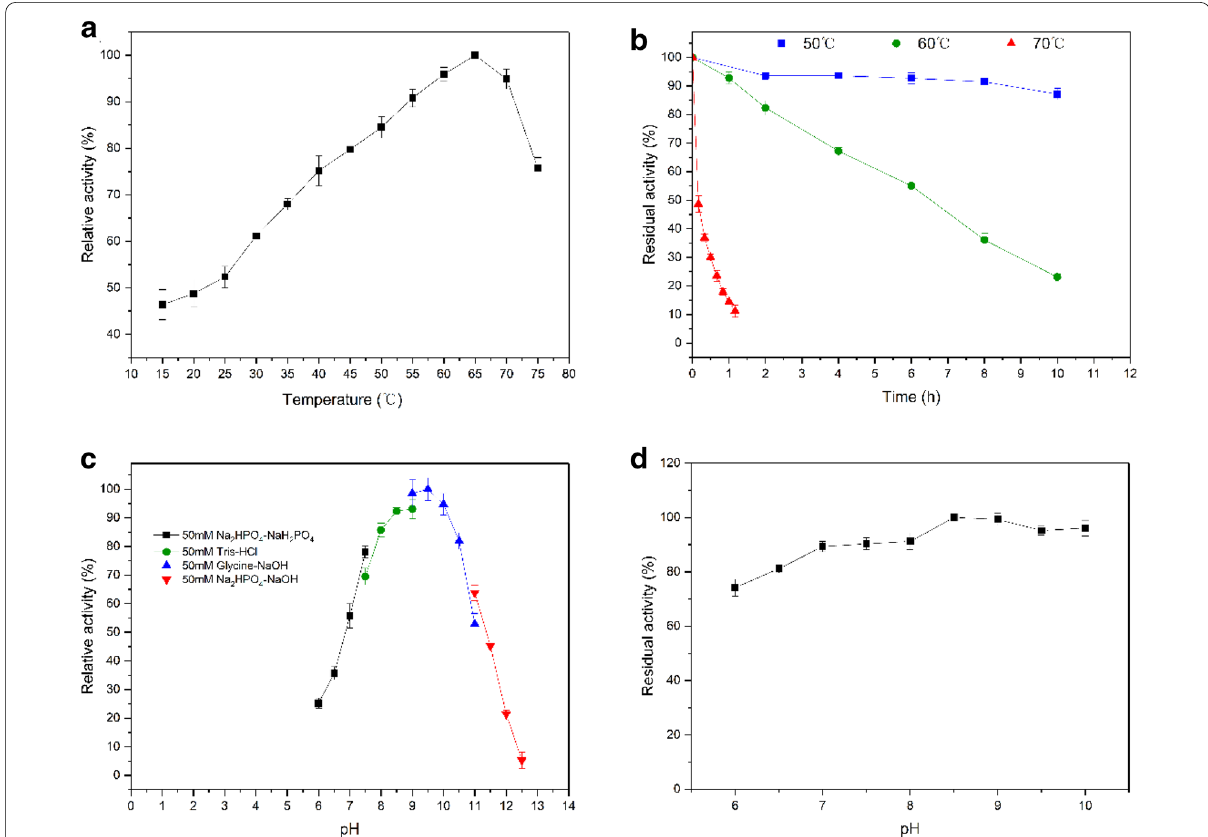
Fig. 7 Characterization of the recombinant CbADH-6M. a Temperature optimum: the enzyme activity was measured at various temperatures (15–75 ℃ ) in phosphate buffer (pH 7.5). b Thermostability: 1.0 μg/mL purified enzyme was incubated at the specific temperature (50, 60, 70) for different times, and the residual activity was measured by standard assay. c pH optimum: the enzyme activity was assayed in various buffers (6.0–12.5) at 35 ℃ . d pH stability: pH stability was measured by incubation of purified enzyme in different buffers (pH 6–10) for 24 h at 35 ℃ , and the residual activity was measured by standard